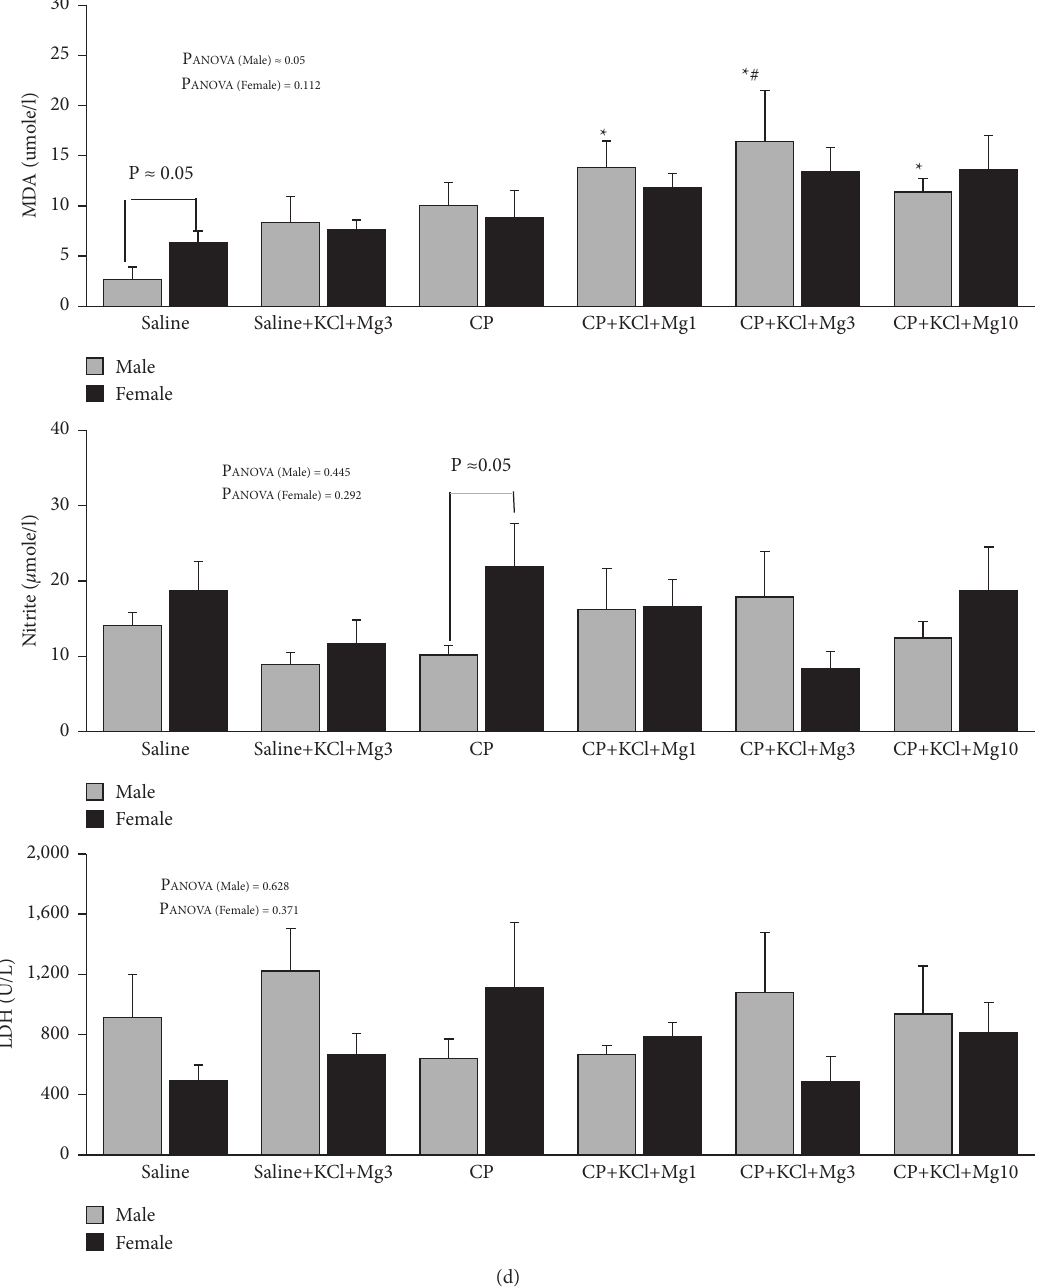
Figure 1: (a) The serum levels of blood urea nitrogen (BUN), creatinine (Cr), and magnesium (Mg), (b) clearance of Cr (ClCr), urine flow (UF), and urinary load of sodium, (c) kidney tissue damage score (KTDS), percentage decrease of body weight (BW), and normalized kidney weight (KW), and (d) the serum levels of malondialdehyde (MDA), nitrite, and lactate dehydrogenase (LDH) in 12 groups of experiments including saline, saline+KCl+Mg3, CP, CP+KCl+ MgSO 4 , CP +KCl+Mg1, CP +KCL+Mg3, and CP +KCl+Mg10 (see Table 1 for groups’ details). ∗ , #, and & indicated significant differences from saline, saline+KCl+Mg3, and CP groups,